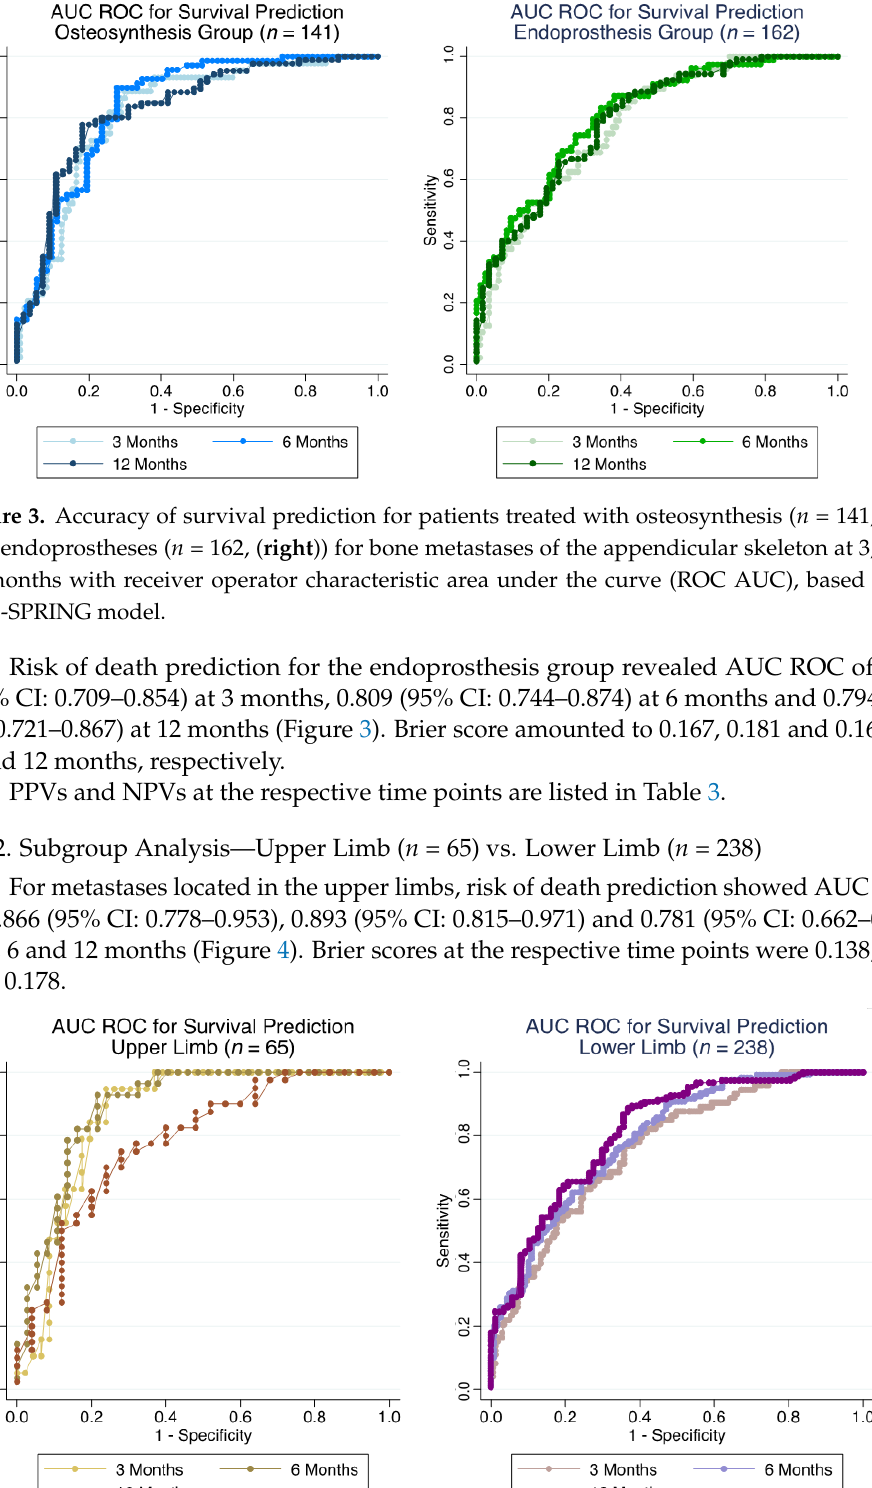
Figure 4. Accuracy of survival prediction for patients with upper limb metastases ( n = 65, (left)) and lower limb metastases ( n = 238, (right)) for bone metastases of the appendicular skeleton at 3, 6 and 12 months with receiver operator characteristic area under the curve (ROC AUC), based on the 2013- SPRING model.